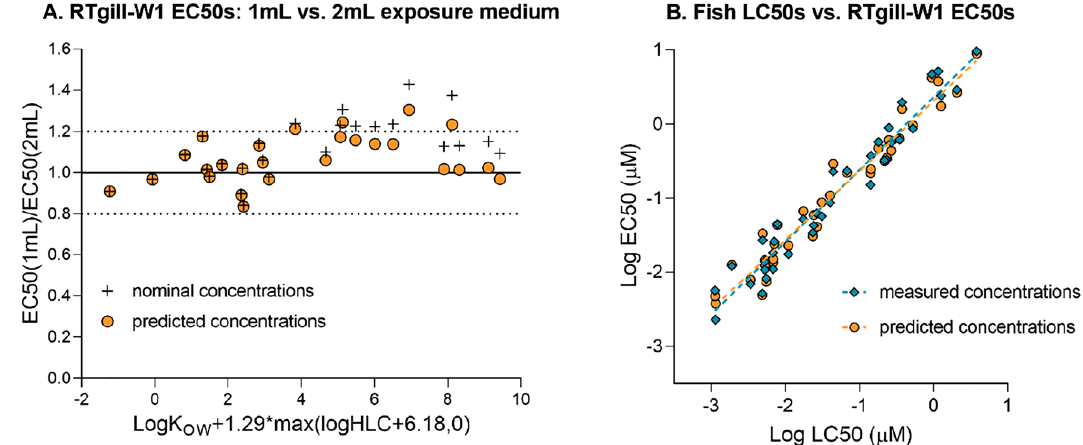
Figure 6. Model applicability for toxicity data. ( A ) Impact of medium volume (1 mL vs. 2 mL) on the difference between the EC50(1 mL) and EC50(2 mL) when nominal or predicted concentrations are used; model